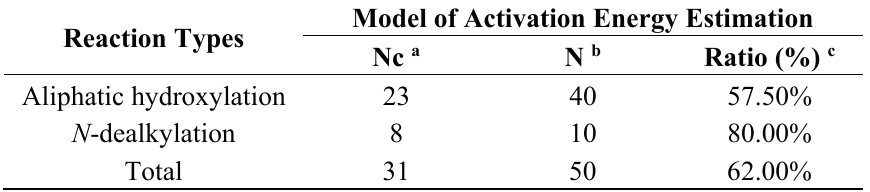
Table 1. Prediction accuracy for CYP3A4 substrates using the top three sites for the activation energy estimation.